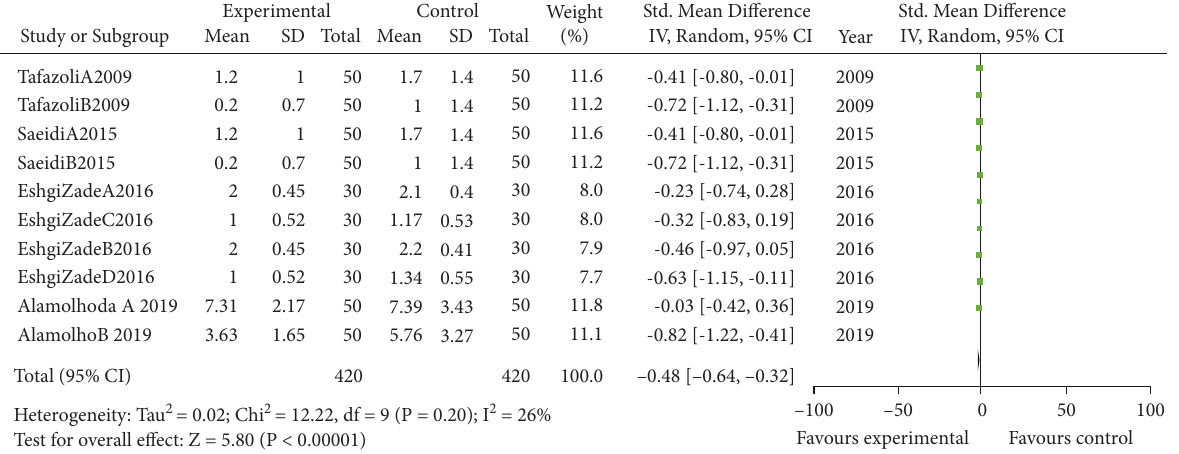
Figure 4: Forest plot of studies that investigated the infuence of Aloe vera on nipple irritation. Random sequence generation (selection bias) Allocation concealment (selection bias) Blinding of participants and personnel (performance bias) Blinding of outcome assessment (detection bias)